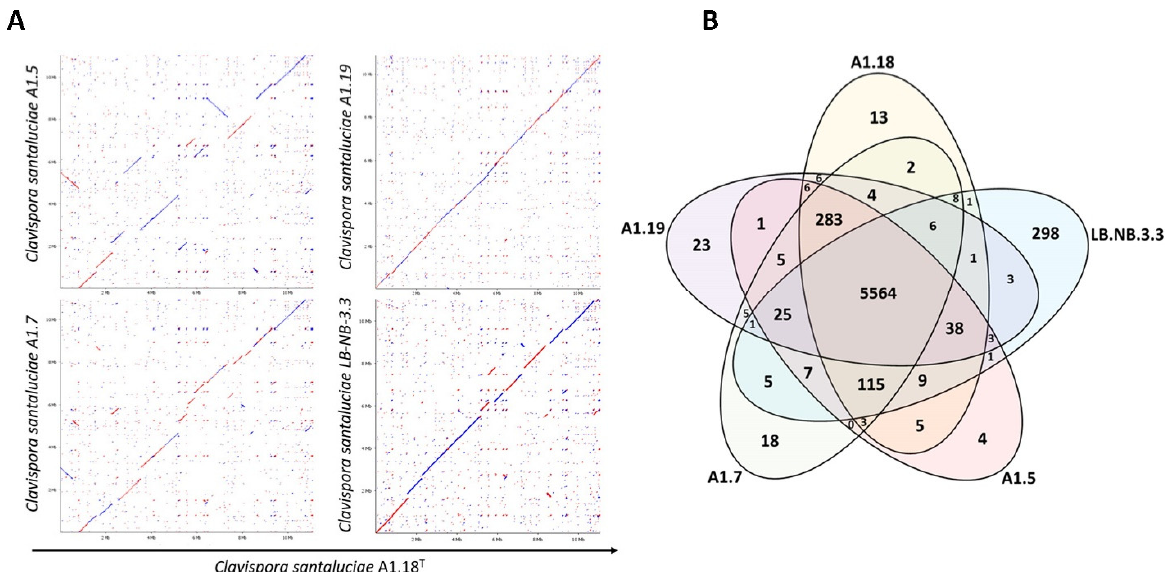
Figure 1. Comparative genomics of Clavispora santaluciae genomes: ( A ) whole-genome dot-plot comparison between the sequenced strains in pairwise mode. Homologous regions are plotted as dots. Red lines link parallel homologous pairs, and blue lines link anti-parallel pairs; ( B ) Venn diagram indicating the number of shared coding genes among Clavispora santaluciae strains.